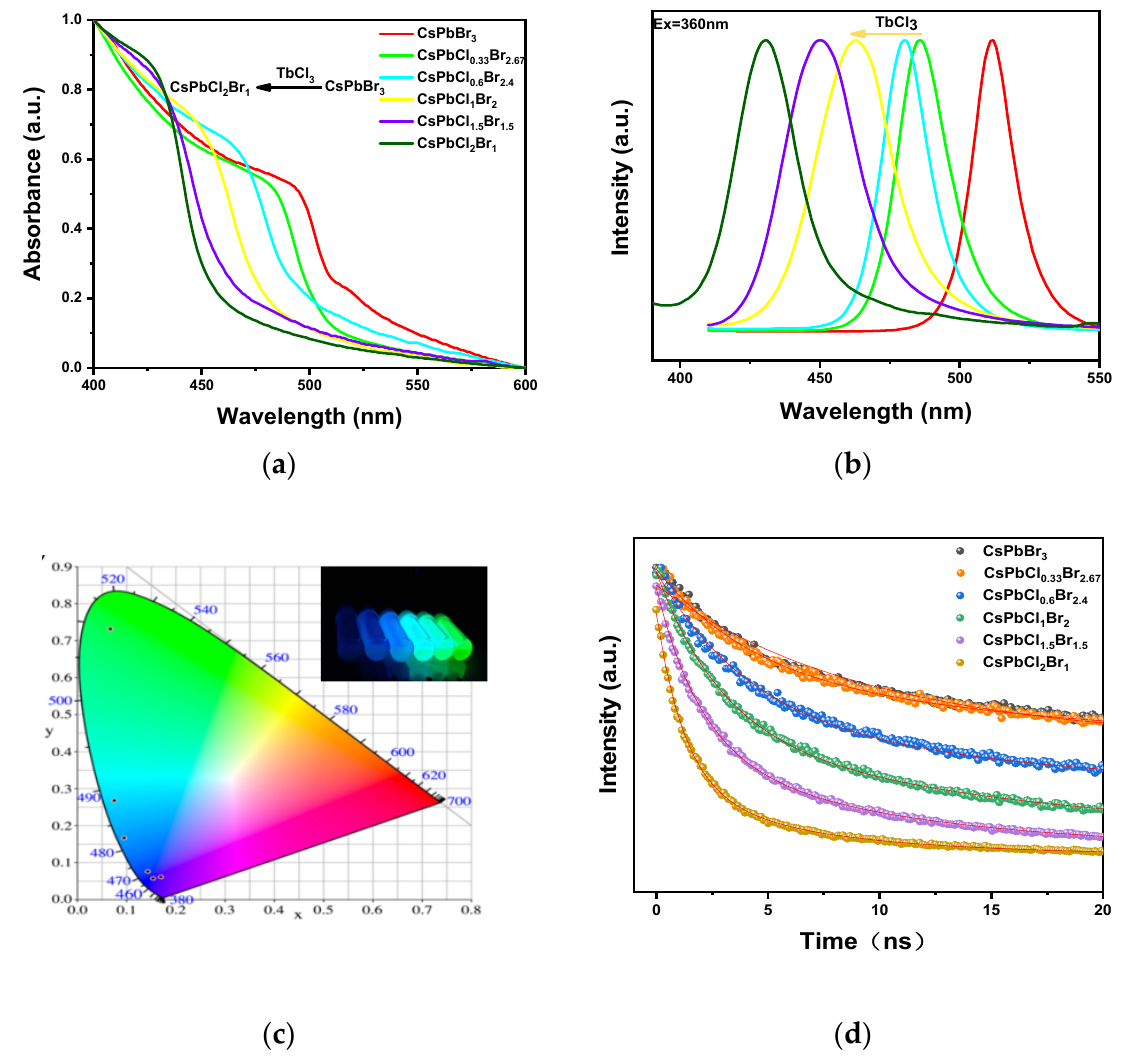
Figure 4. ( a ) Ultraviolet absorption spectra of CsPbCl x Br 3-x nanocrystals with different halogen components; ( b ) the fluorescence emission spectra of CsPbCl x Br 3-x nanocrystals with different halogen components (from left to right are CsPbCl 2 Br 1 , CsPbCl 1.5 Br 1.5 , CsPbCl 1 Br 2 , CsPbCl 0.6 Br 2.4 , CsPbCl 0.33 Br 2.67 , and CsPbBr 3 ). ( c ) The CIE diagram of different halogen components of CsPbCl x Br 3-x nanocrystals. The illustration shows the photos of the synthesized CsPbCl x Br 3-x nanocrystals under the ultraviolet lamp; ( d ) fluorescence lifetime diagrams of CsPbCl x Br 3-x nanocrystals with different halogen components.